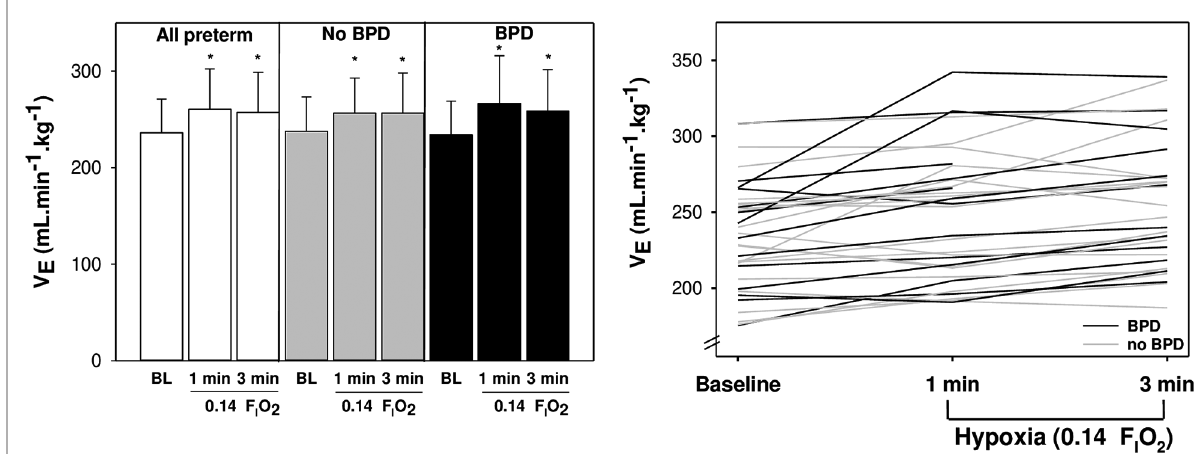
FIGURE 3 Mean±SD (left) and individual (right) minute ventilation ( V E ) is shown at baseline and during 14% O 2 for preterm infants with (black) and without (grey) bronchopulmonary dysplasia. *indicates different from baseline ( p